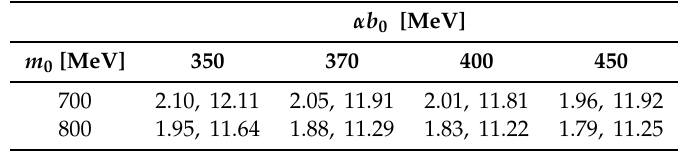
Table 5. Maximal neutron-star masses in units of M (cid:12) and corresponding radius in km (separated by comma) for different values of m 0 and α b 0 parameters.